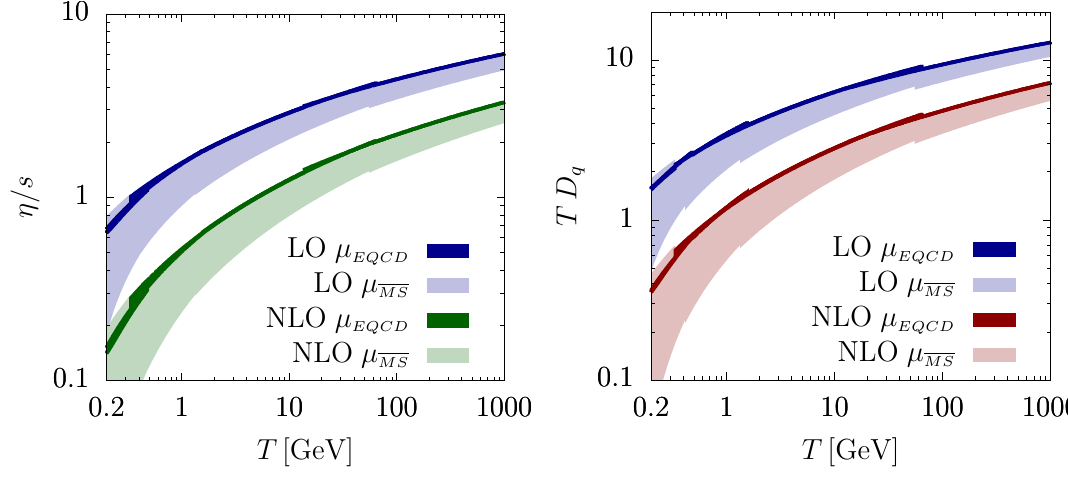
Figure 1 . (a) The shear viscosity to entropy density ratio and (b) baryon number di(cid:11)usion co- e(cid:14)cient as a function of temperature, at leading-order (LO) and at next-to-leading order (NLO) for di(cid:11)erent choices of the running coupling. The solid band (cid:12)xes the coupling using the two-loop EQCD value with (cid:22) EQCD = (2 : 7 4 (cid:25) ) T , while the shaded band uses the standard MS two-loop $ coupling with (cid:22) = ( (cid:25) 4 (cid:25) ) T ; the corresponding values of (cid:11) s ( T ) are presented in (cid:12)gure 8. The MS $ dominant NLO correction arises from NLO modi(cid:12)cations of ^ q as is illustrated (cid:12)gure 6. The uncer- tainty arising from gain terms which are only estimated (and not computed) is shown in (cid:12)gure